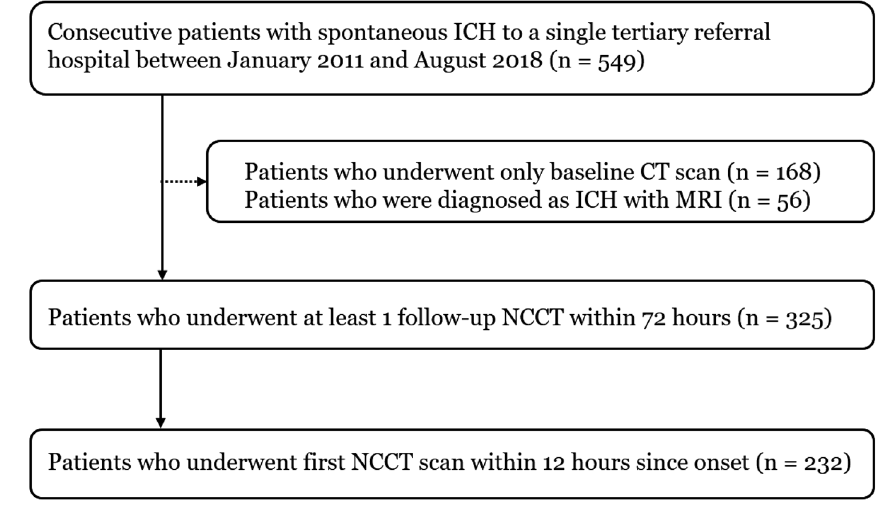
Figure 1. Flow diagram of patient selection. ICH, Intracerebral hemorrhage; CT, computed tomography; MRI, magnetic resonance imaging; NCCT, non-contrast computed